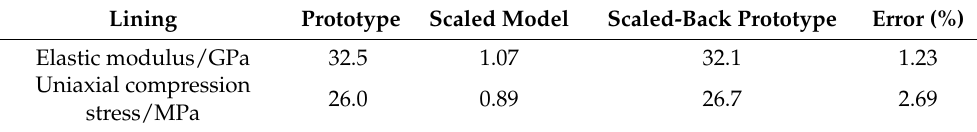
Table 4. Physical and mechanical parameters of the prototype and scaled model of the lining structure. Lining